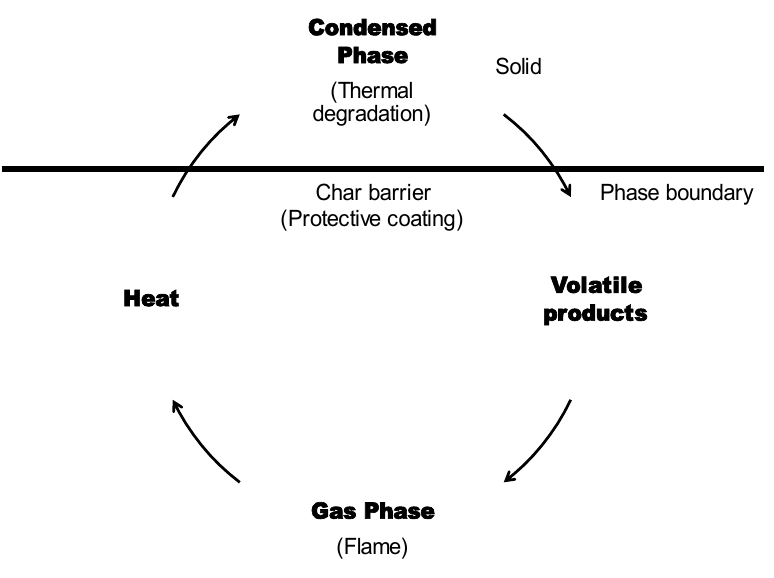
Figure 3. Flame retardant mechanisms.